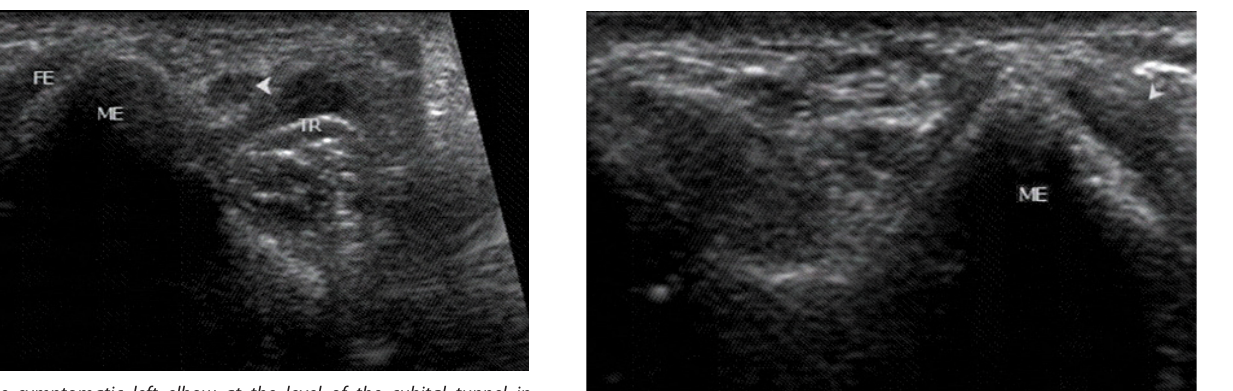
Fig. 2. The symptomatic left elbow at the level of the cubital tunnel in extension. The ulnar nerve (arrowhead) and the medial head of triceps (TR) are in the cubital tunnel posterior to the medial epicondyle (ME) similarly to the anatomy of the extended right elbow. Note the round contour of the cross- section of the ulnar nerve.